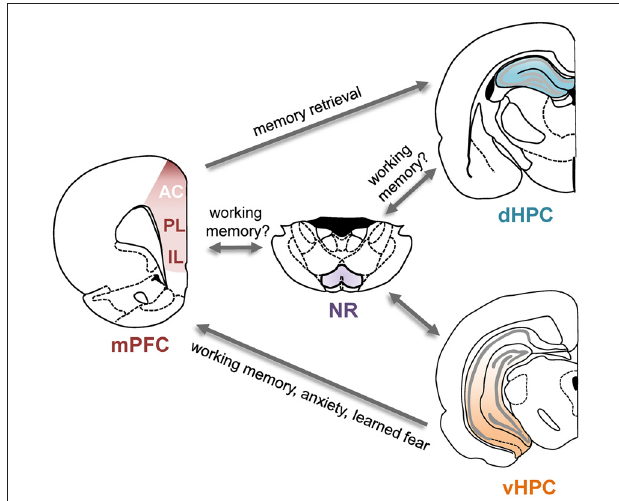
FIGURE 1 | Direct and indirect connections between the prefrontal cortex (PFC) and hippocampus and their functional roles. Schematic of the direct and some of the indirect connections between the hippocampus and PFC. Arrows indicate direction of the projections. Functional roles of these projections are indicated in the text next to the arrows; for details and supporting references, see main text. AC, anterior cingulate cortex; dHPC, dorsal hippocampus; IL, infralimbic cortex; mPFC, medial prefrontal cortex; NR, nucleus reuniens; PL, prelimbic cortex; vHPC, ventral hippocampus.